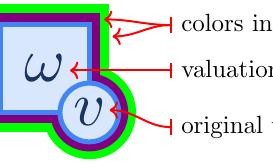
Figure 4: A vertex of a possible worlds diagram